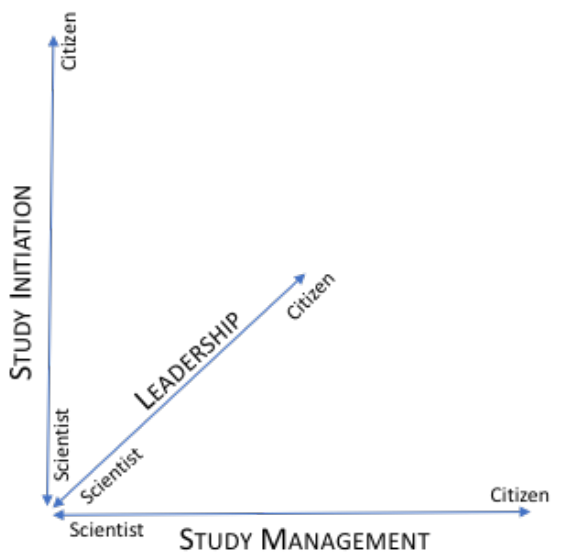
Figure 3: Dimensions for role adoption for CHS